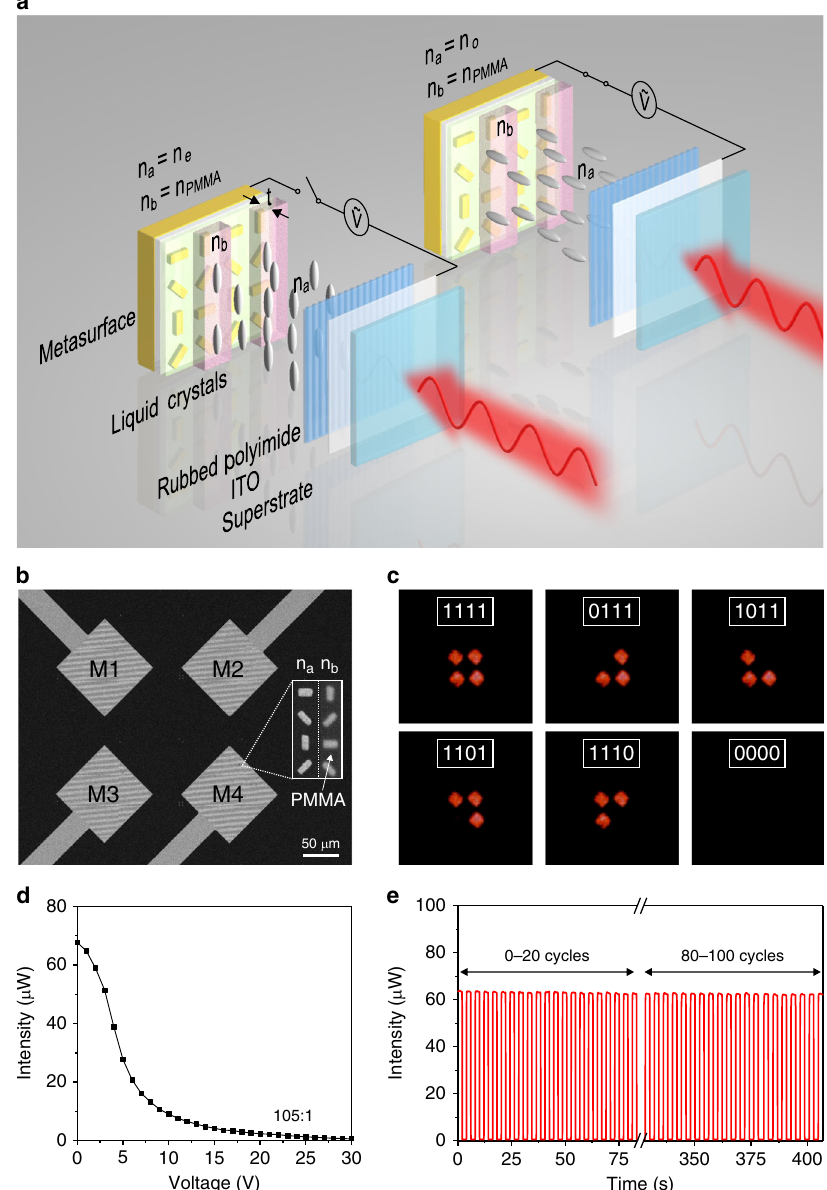
Fig. 3 Working principle and performance of the 4-bit DMSD. a Schematic of the electrically-controlled DMSD. An array of gold nanorods spaced by PC403 resides on a gold electrode. All nanorods are embedded in another PC403 layer of 50 nm. The alternating columns are then either covered by high- birefringence LCs ( n a ) or by a PMMA ( n b ) trench of thickness t . Δ φ p is fi nely tuned, when n a is dynamically changed upon electric control of the LCs and n b is fi xed. n o and n e are the ordinary and extraordinary refractive indices of the LCs, respectively. The incident light (633 nm) is linearly polarized along the PMMA trenches. b SEM image of the DMSD. Four addressable metasurface pixels (M1 – M4) are controlled via four independent gold electrodes. Inset: 0111 ” , etc.) is dynamically generated by the 4-bit DMSD. d Intensity of the anomalously re fl ected light as a function of the applied voltage V. An